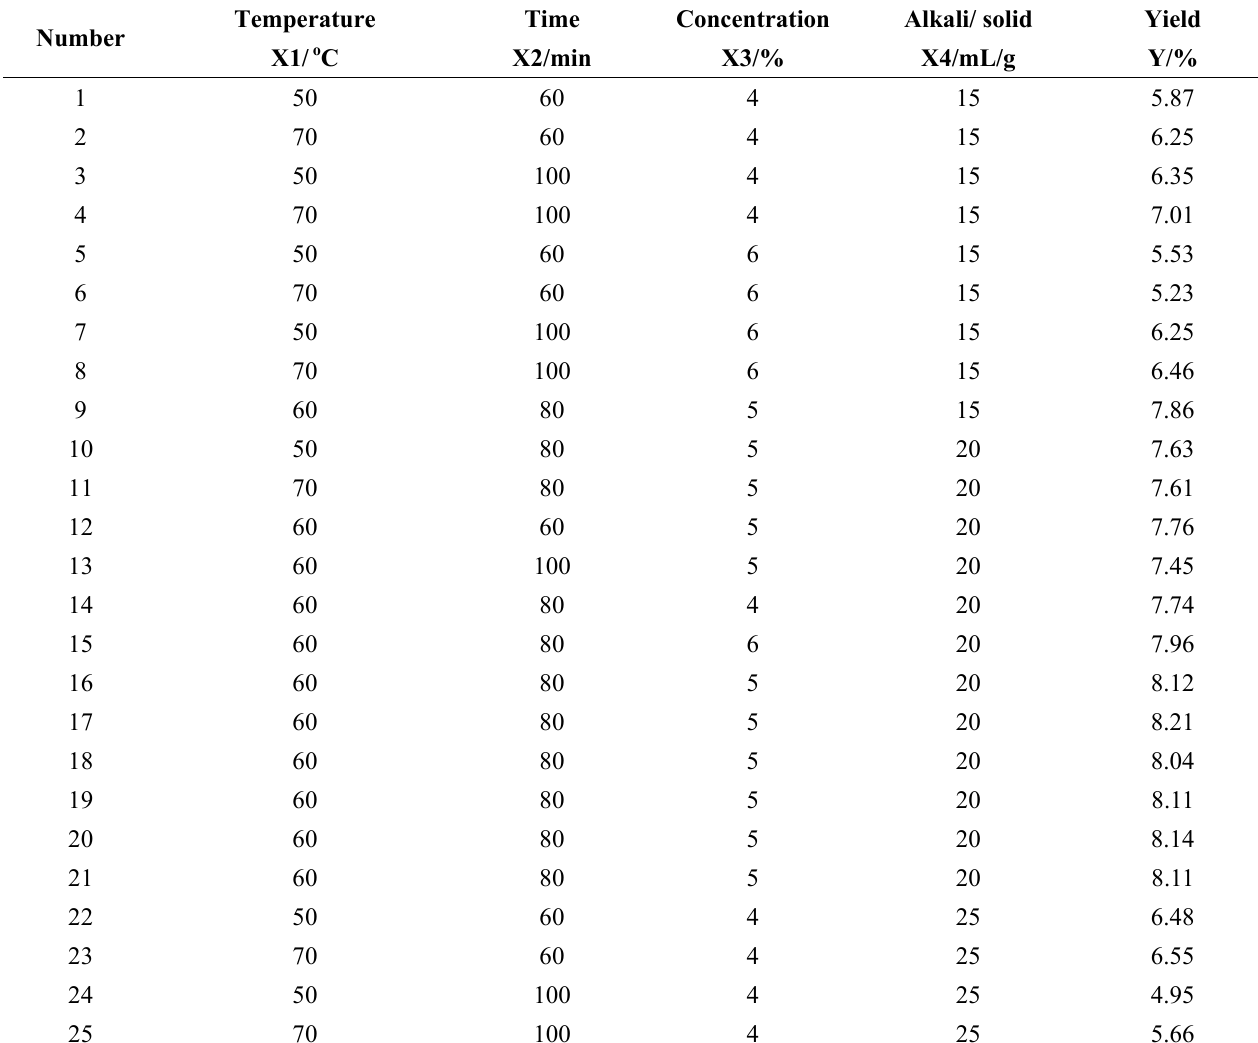
polysaccharides from Ganoderma